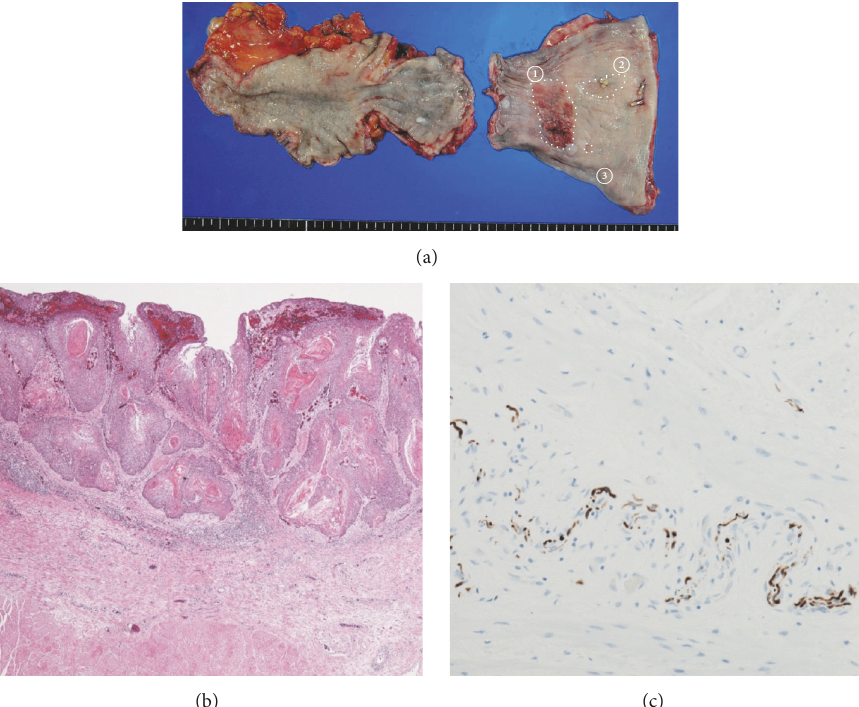
Figure 4: Resected specimen (a). There are three lesions ( A – C ) in the markedly dilated esophagus. Moderately differentiated SCC cells invaded the submucosal layer at elevated lesion (b). Loss of ganglion cells in the myenteric plexus throughout the length of the resected esophagus